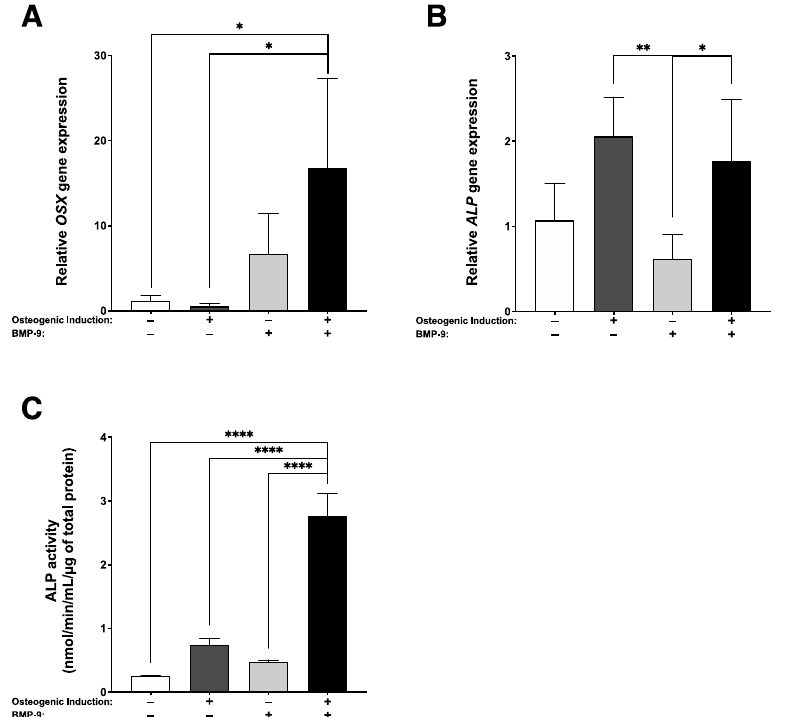
Figure 2. Superior osteogenic profile of the BMP-9 treated bone-like substitutes. Gene expression of ( A ) osterix ( OSX ) and ( B ) alkaline phosphatase ( ALP ) were measured by RT-qPCR on substitutes cultured for 21 days. ( C ) For osteogenically induced substitutes treated with 1 nM of rhBMP-9, ALP activity was higher compared to other conditions. (One-way ANOVA with a Bonferroni’s multiple comparison post-hoc test, * p < 0.05, ** p < 0.01, **** p < 0.0001).